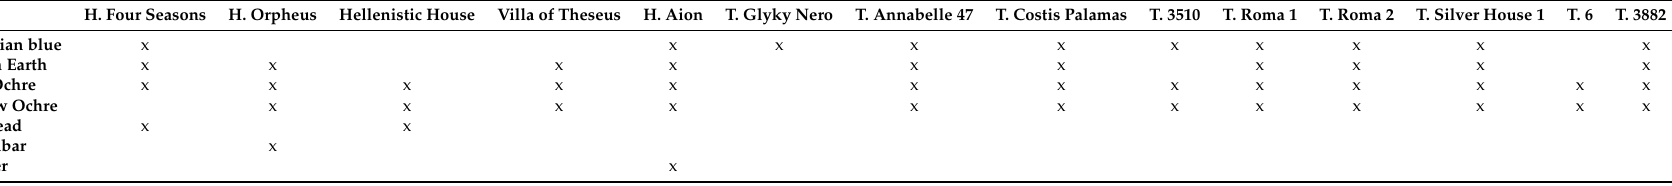
Table 2. Pigments identified at each site.